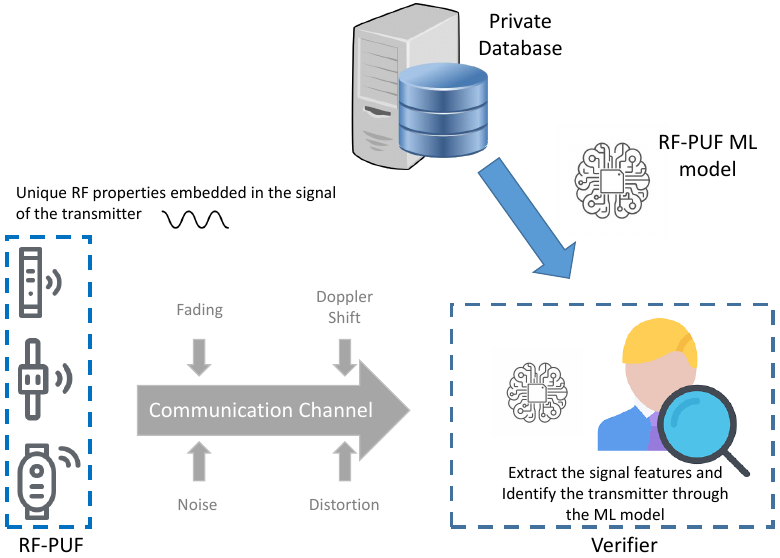
Figure 15. High-Level representation of the RF-PUF